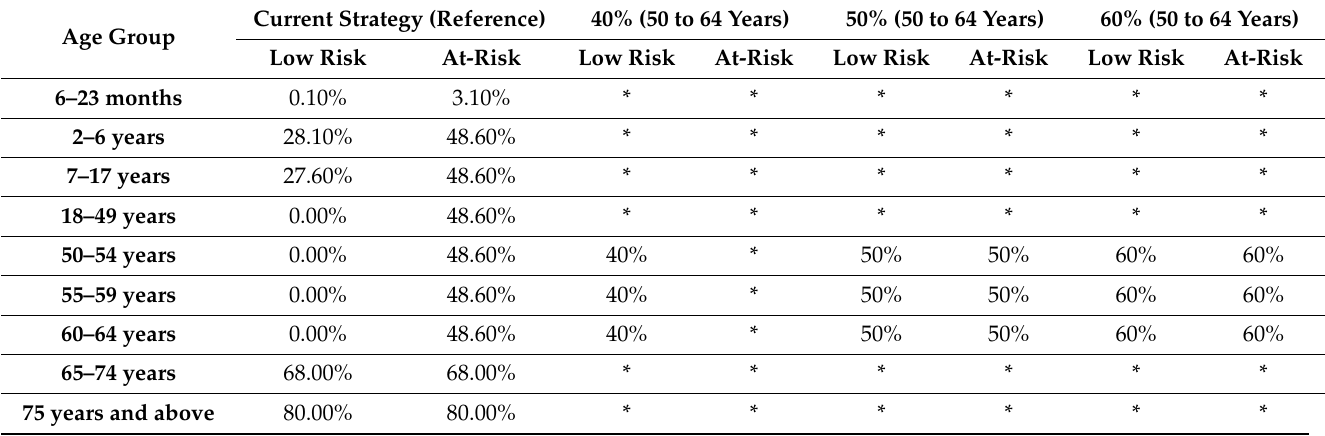
Table 1. Vaccine coverage for the strategies compared in the